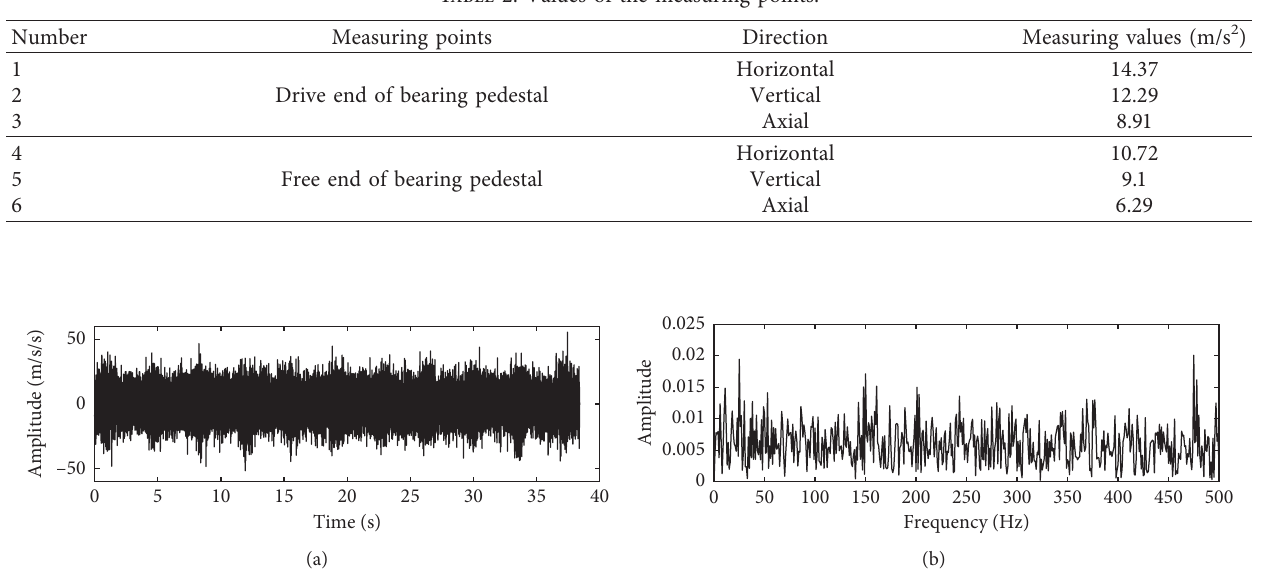
Figure 11: Vibration signal of the drive end of bearing pedestal measuring point in horizontal direction: (a) time-domain waveform of the vibration signal; (b) EDS of the vibration signal as shown in Figure